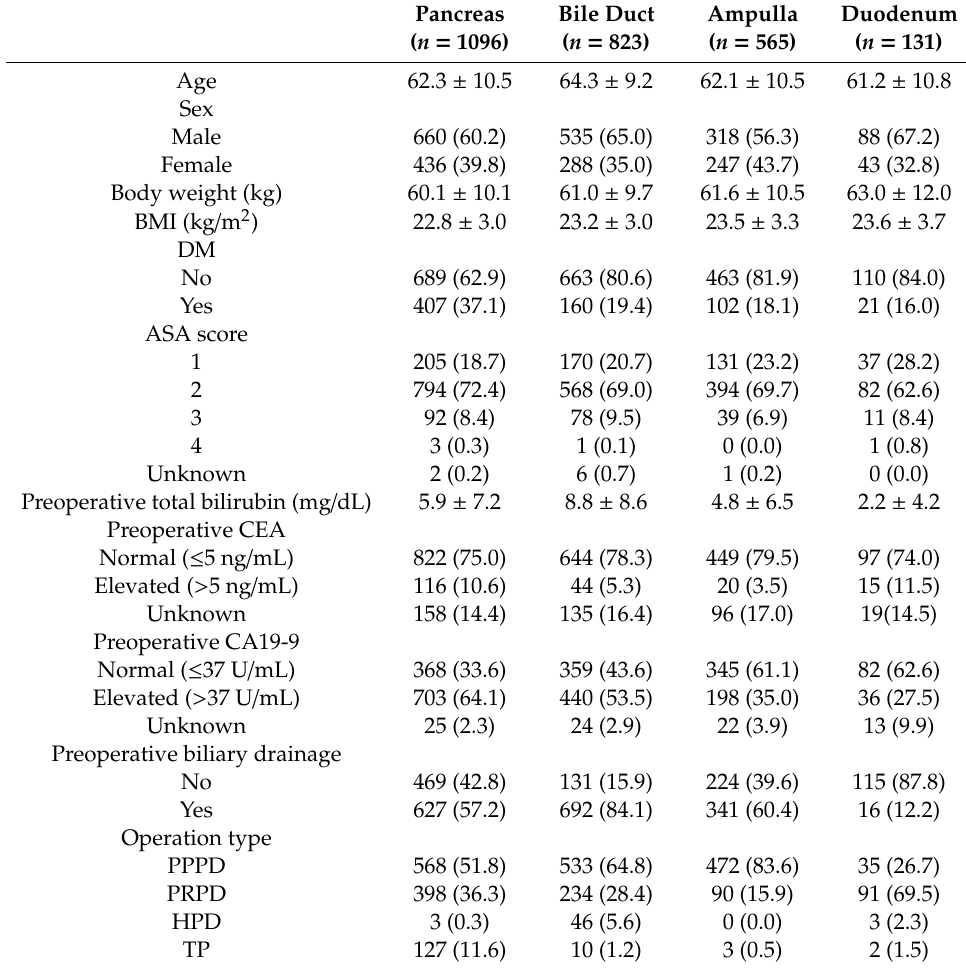
Table 2. Clinical and operative features of 2615 patients with malignant tumor (Mean ± Standard deviation and number